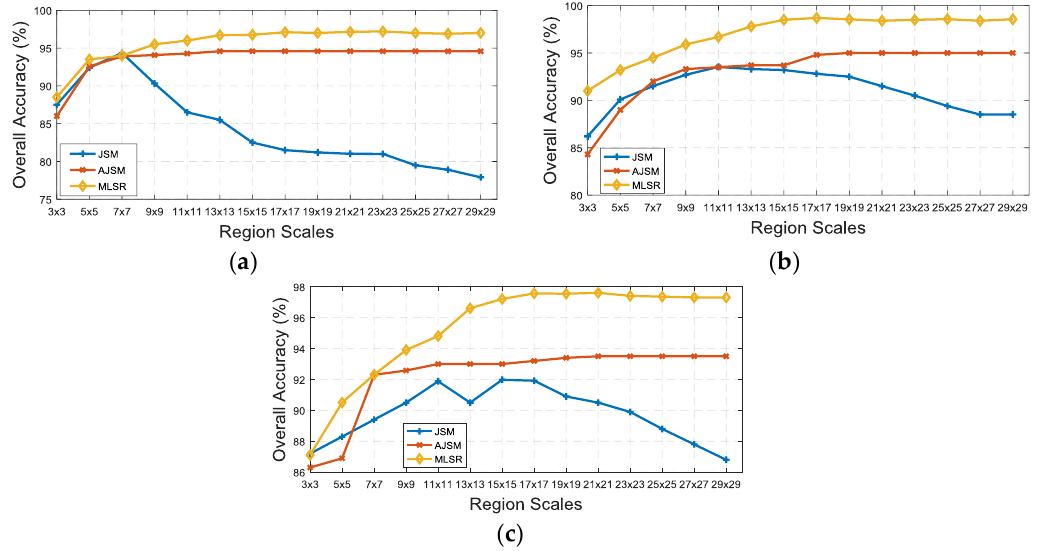
Figure 7. The effects of region scales on JSM, AJSM, and MLSR: ( a ) Indian Pines ( b ) Pavia University and ( c ) the Salinas